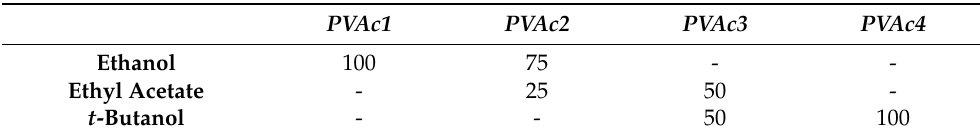
Table 1. Solvent mixtures used in the polyvinyl-acetate (PVAc) synthesis in order to control the molecular